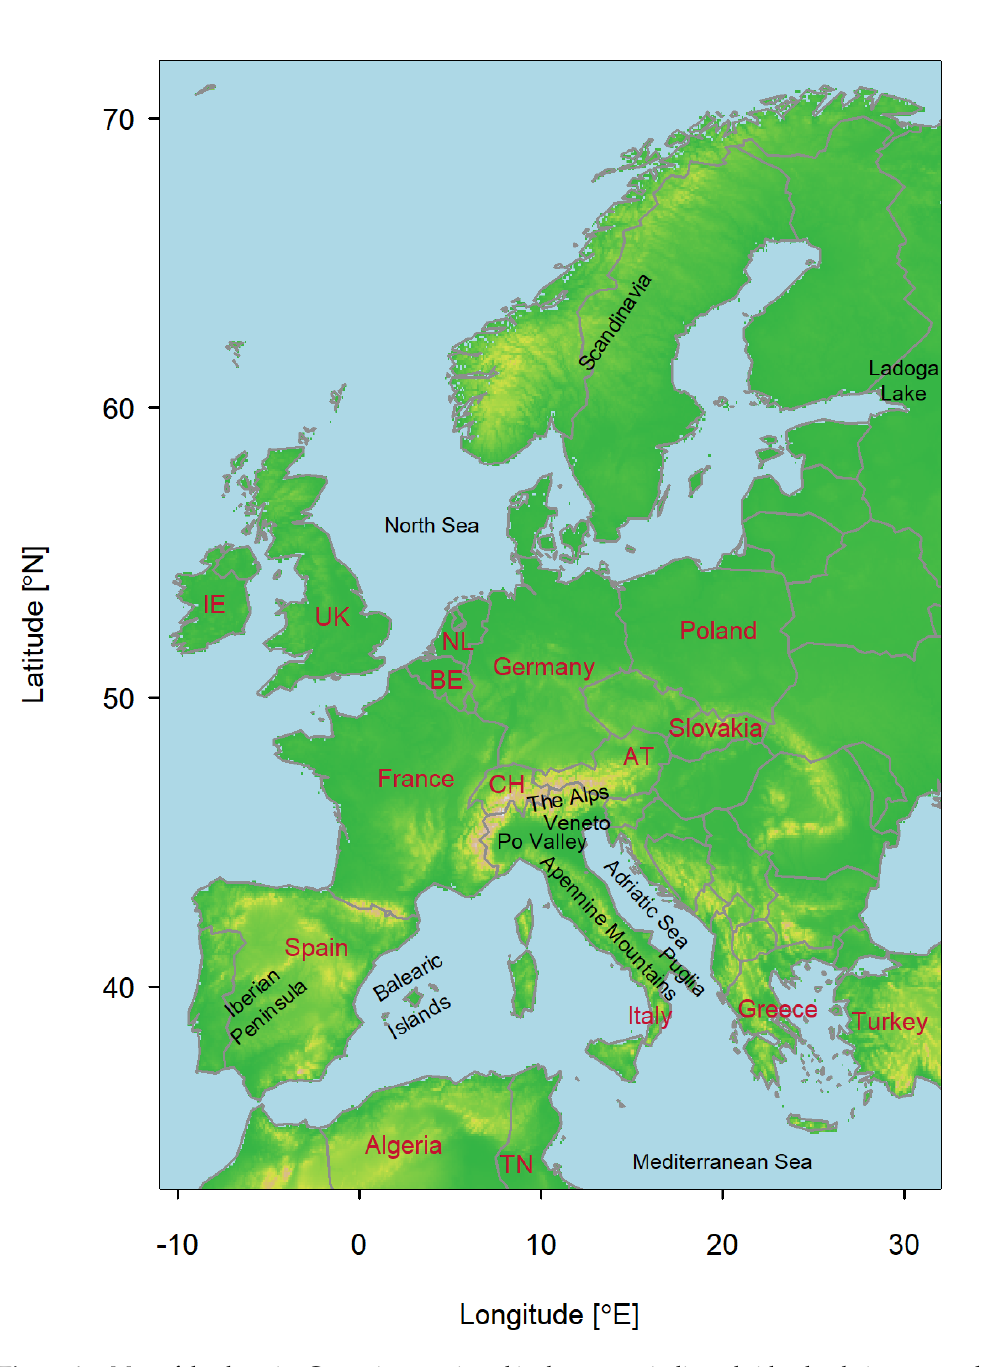
Figure A1. Map of the domain. Countries mentioned in the text are indicated either by their name or the two-letter ISO code in red: Austria (AT), Belgium (BE), Switzerland (CH), Ireland (IE), the Netherlands (NL), Tunisia (TN) and United Kingdom (UK). Other regions mentioned in the paper are named as